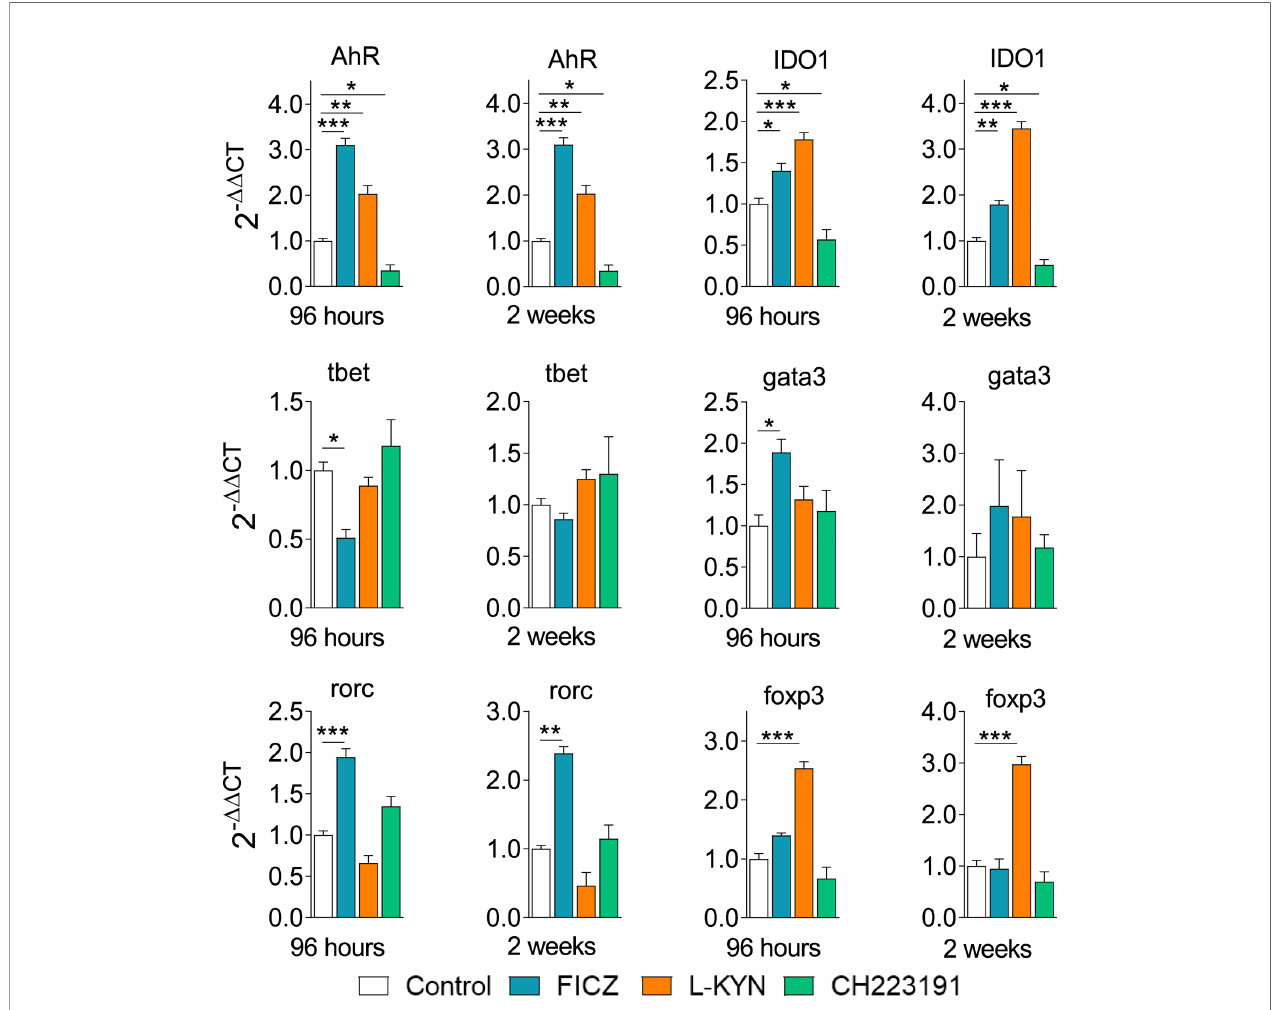
FIGURE 9 | Treatment with AhR ligands alters the expression of mRNA for IDO, AhR, and transcription factors in the lungs of P. brasiliensis infected mice. C57BL/6 mice (n = 5) were infected with 1 x 10 6 P. brasiliensis yeasts and treated with FICZ, L-Kyn, CH223191 as previously described. Control mice were treated with PBS. The animals were sacri fi ced 96 hours and 2 weeks after infection, their lungs removed, macerated, and the RNA obtained was analyzed by RT-PCR as described in M&M. The experiment was repeated twice, and data are expressed as M ± SD. P values < 0.05 were considered signi fi cant (* p < 0.05; ** p < 0.005 and *** p <